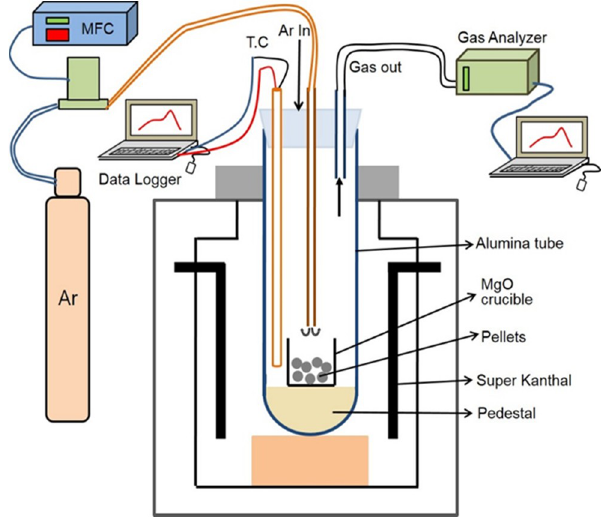
Figure 1. Schematic diagram of the experimental settings. Table 1. Preliminary experimental conditions for the synthesis of SiC from Si sludge. Mixing Ratio Reaction Temp. (Si Sludge/C)